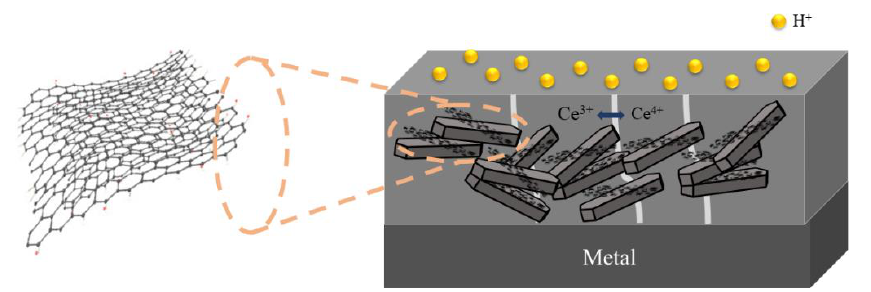
Figure 12. CeO 2 –GO/EP coating under acidic medium. Figure 12 . CeO 2 – GO/EP coating under acidic medium.